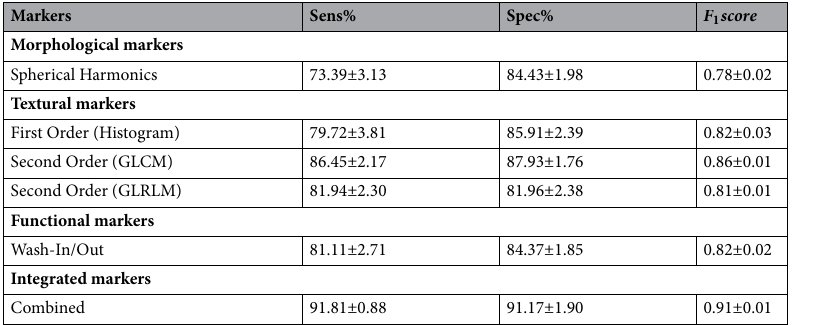
Table 4. Comparison of the first stage classification performance using the individual markers namely, SHs morphological markers, First order textural markers, second order GLCM textural markers, second order GLRLM textural markers, and wash-in/out slopes functional markers of the developed CAD system: Benign (LR1-2) vs. Intermediate (LR3) vs. Malignant (LR4-5) using RFs classifier. Note that: Sens and Spec denote Sensitivity and Specificity, respectively.